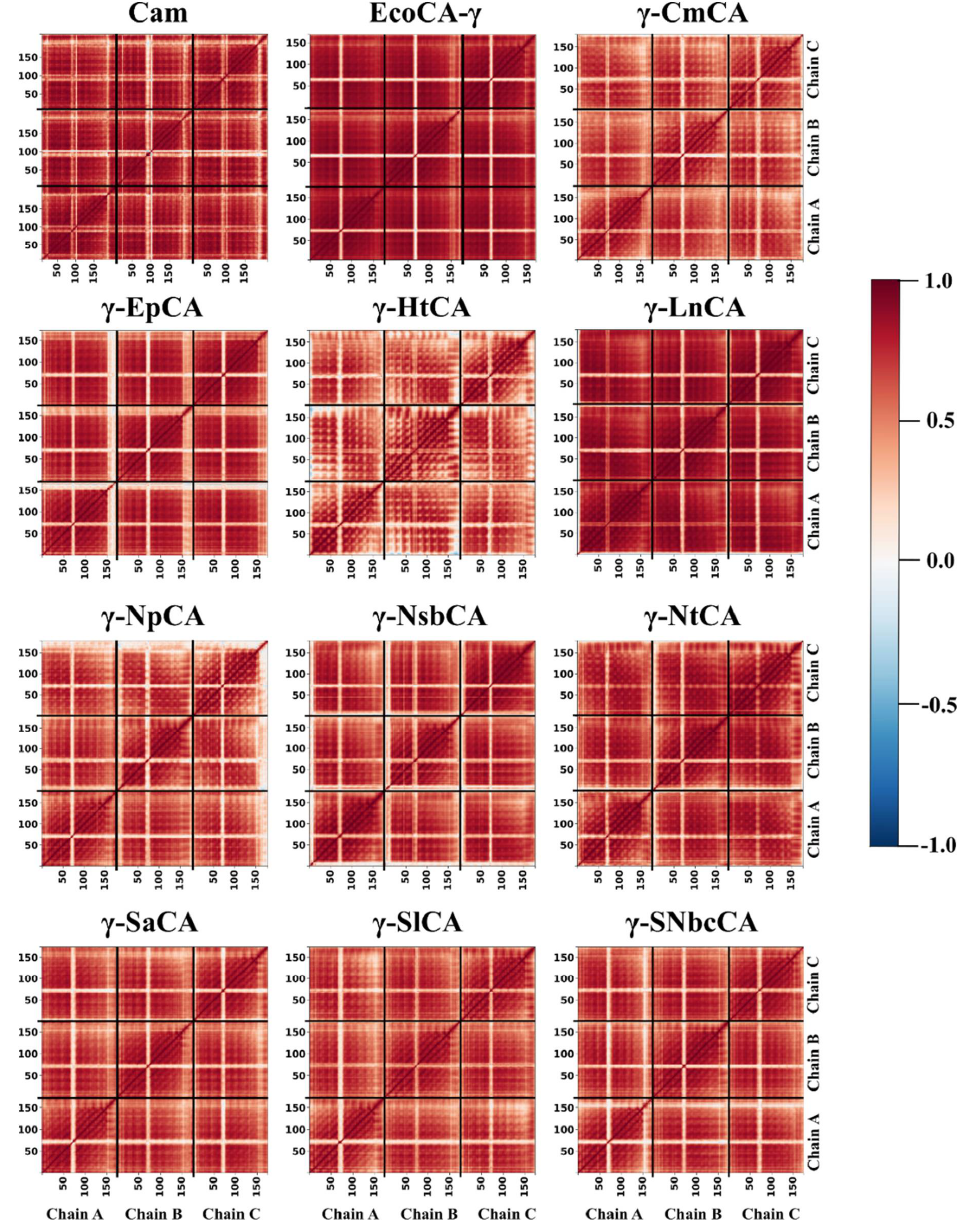
Figure 9. Dynamic cross correlation (DCC) heatmaps for γ-CAs simulated.